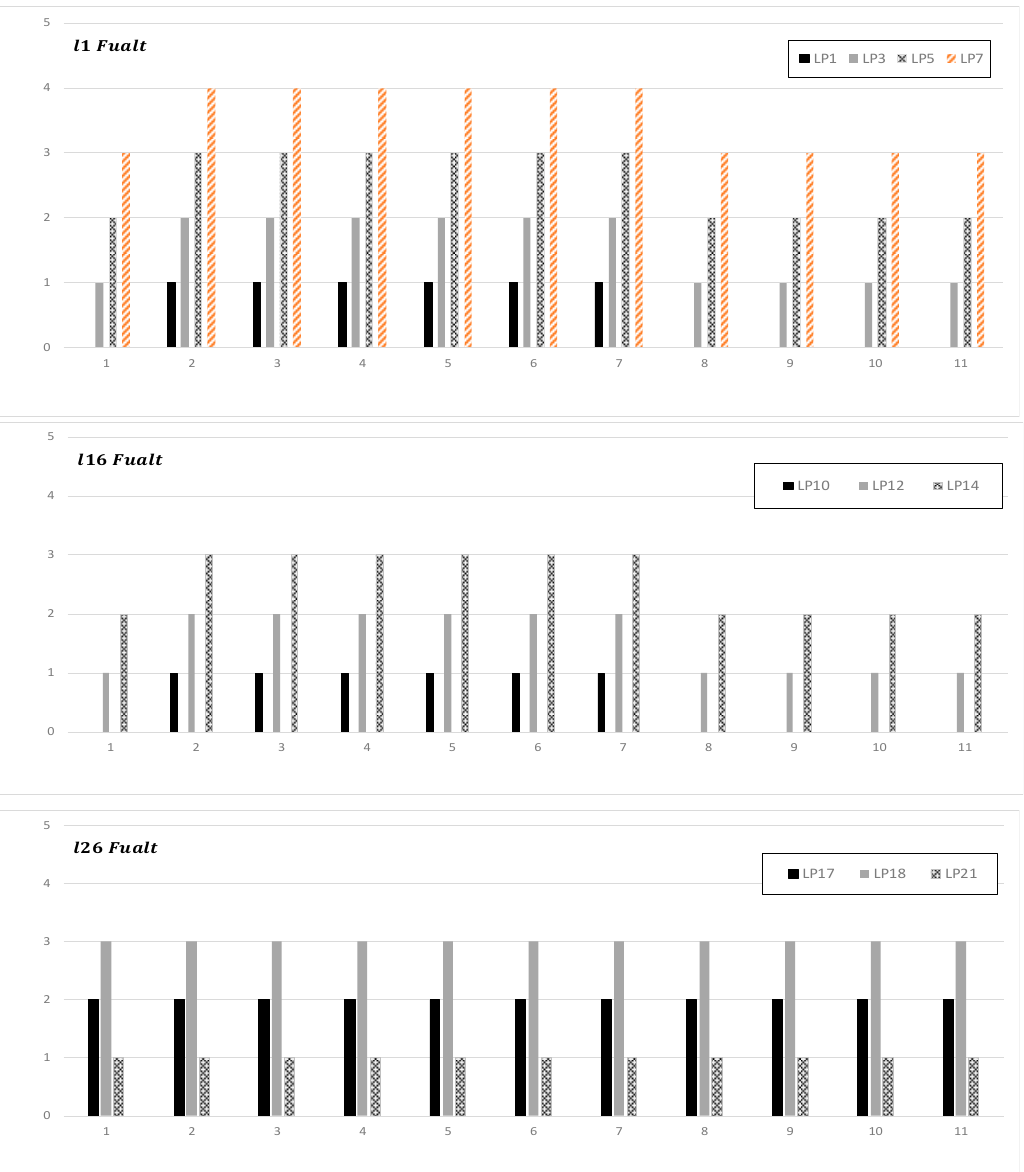
Figure 9. Load priority according to the fault section and fault time.